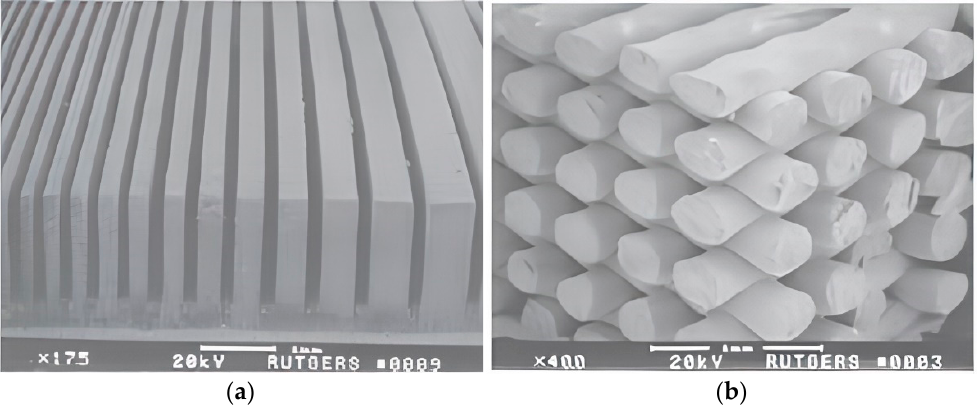
Figure 8. ( a ) 3D-printed connectivity piezocomposite (2-2); ( b ) 3D-printed connectivity piezocomposite (3-3) (Reprinted from Ref. [74], copyright (2007), with the kind permission of Springer Science + Business Media LLC).